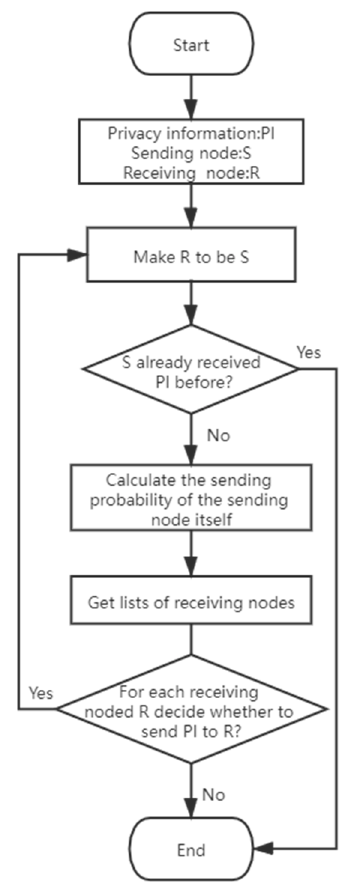
Figure 1. The procedure of privacy information dissemination.